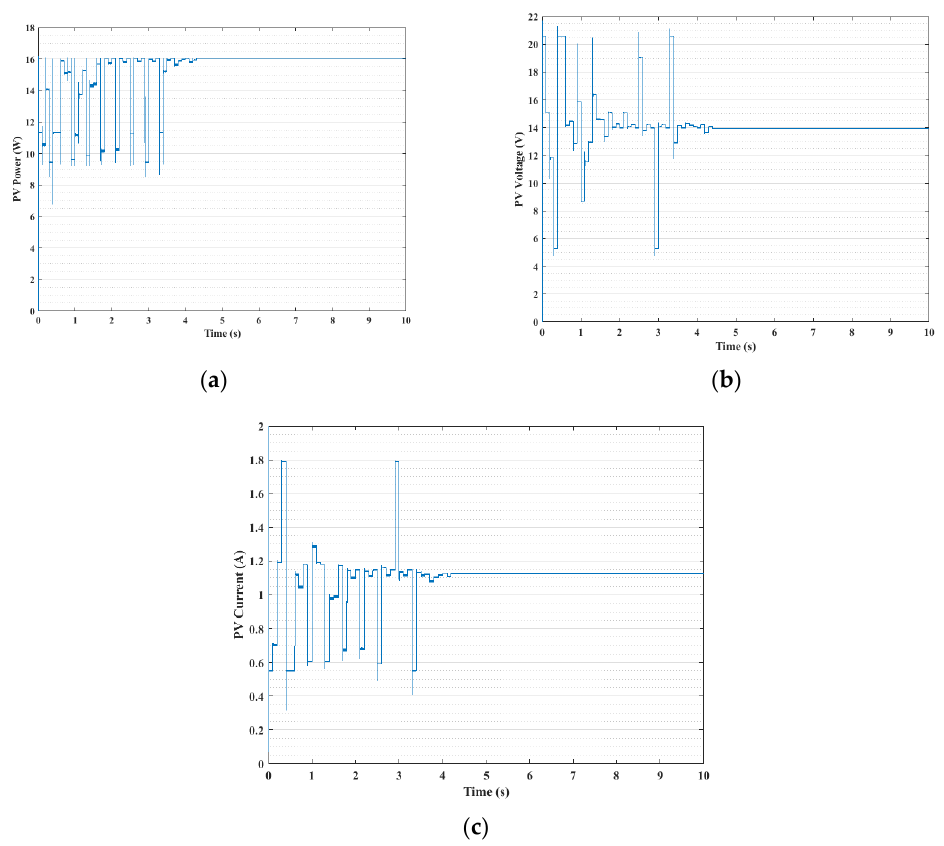
Figure 15. Modified LFO at PSC3 ( a ) power ( b ) voltage ( c ) current.